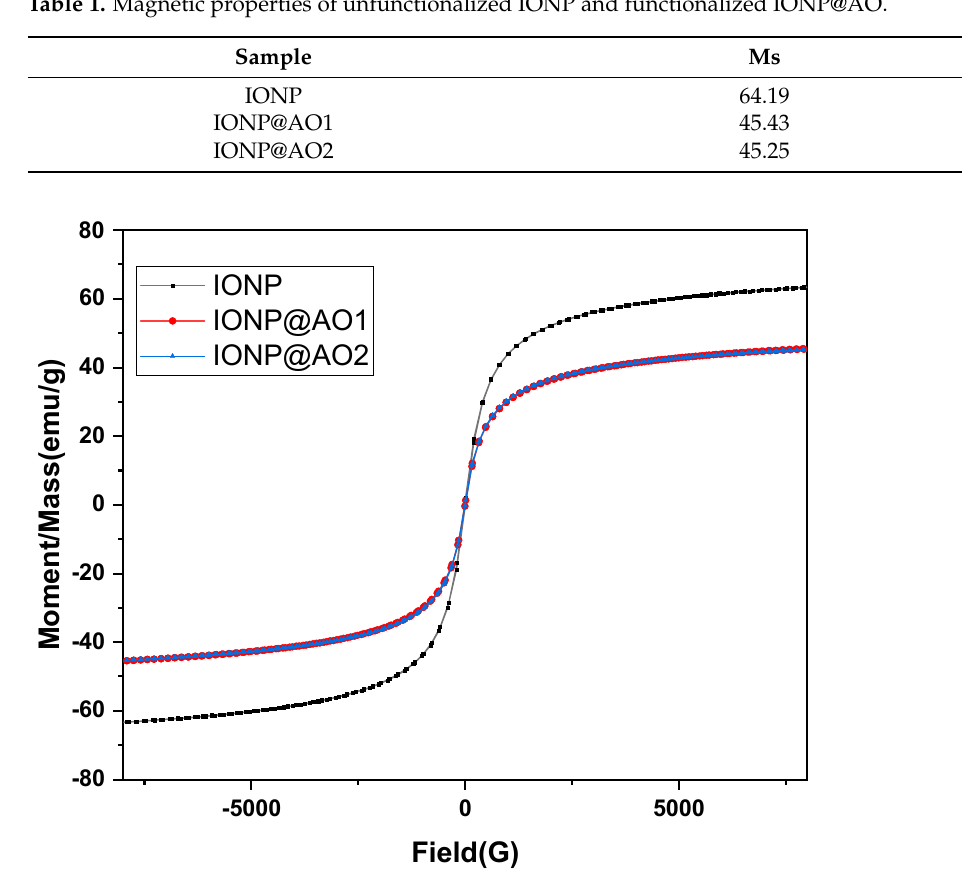
Figure 6. Room-temperature hysteresis loops for unfunctionalized IONP and functionalized IONP@AO.